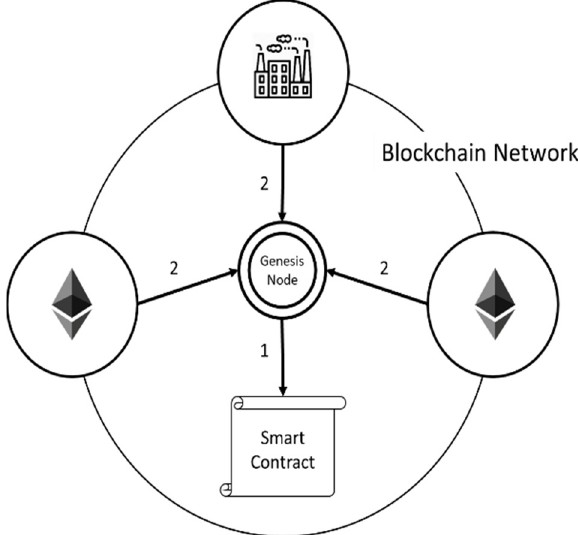
Figure 3. Blockchain network setup.